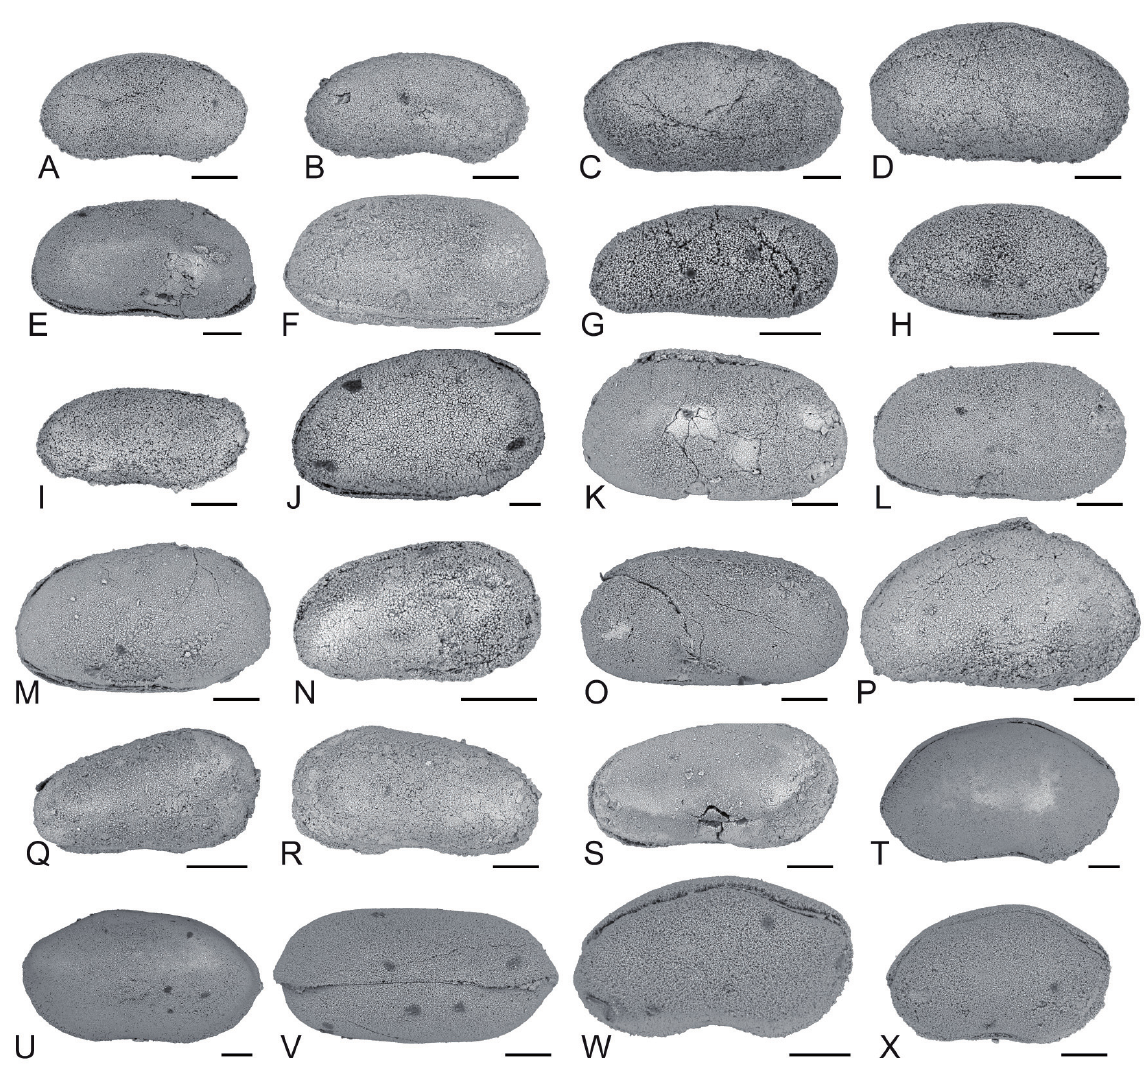
Fig. 11. Ostracods from the Dajiang section, South China. — A–B . Bairdiacypris sp. 8. A . Carapace, right lateral view, P6M3058. B . Carapace, right lateral view, P6M3059. — C–D . Bairdiacypris sp. 9. C . Carapace, right lateral view, P6M3060. D . Carapace, right lateral view, P6M3061. — E–F . Bythocypris ? sp. 1. E . Carapace, right lateral view, P6M3062. F . Carapace, right lateral view, P6M3063. — G . Bythocypris sp. 2, carapace, right lateral view, P6M3064. — H . Bythocypris ? sp. 3, carapace, right lateral view, P6M3065. — I . Fabalicypris parva Wang, 1978, carapace, right lateral view, P6M3066. — J–N . Liuzhinia antalyaensis Crasquin–Soleau, 2004. J . Carapace, right lateral view, P6M3067. K . Carapace, left lateral view, P6M3068. L . Carapace, left lateral view, P6M3069. M . Carapace, right lateral view, P6M3070. N . Carapace, right lateral view, P6M3071. — O . ? Liuzhinia antalyaensis Crasquin– Soleau, 2004, carapace, left lateral view, P6M3072. — P . Liuzhinia sp., carapace, right lateral view, P6M3073. — Q–S . Liuzhinia sp. 2. Q . Carapace, right lateral view, P6M3074. R . Carapace, left lateral view, P6M3075. S . Carapace, right lateral view, P6M3076. — T–X . Orthobairdia jeanlouisi sp. nov. T . Holotype, carapace, right lateral view, P6M3077. U . Carapace, left lateral view, P6M3078. V . Paratype, carapace, dorsal view, P6M3079. W . Carapace, right lateral view, P6M3080. X . Carapace, right lateral view, P6M3081. – Scale = 100